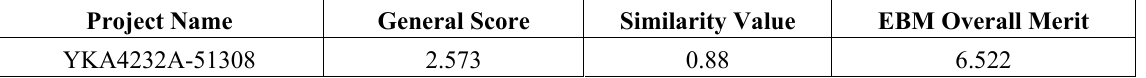
Table 7. Result of estimated process route EBM overall merit.